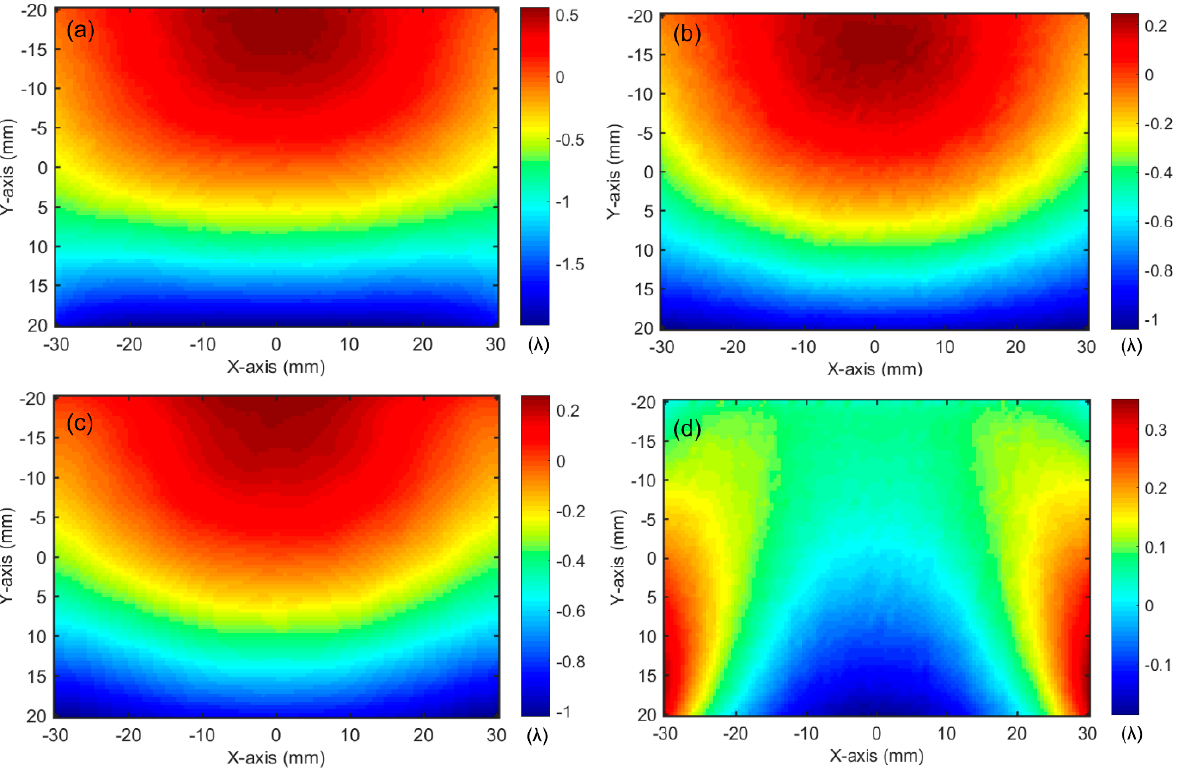
Figure 16. Calculated wavefront aberrations after single pass: ( a ) total wavefront aberration; ( b ) temperature-induced wavefront aberration; ( c ) stress-induced wavefront aberration; ( d ) deformation-induced wavefront aberration.